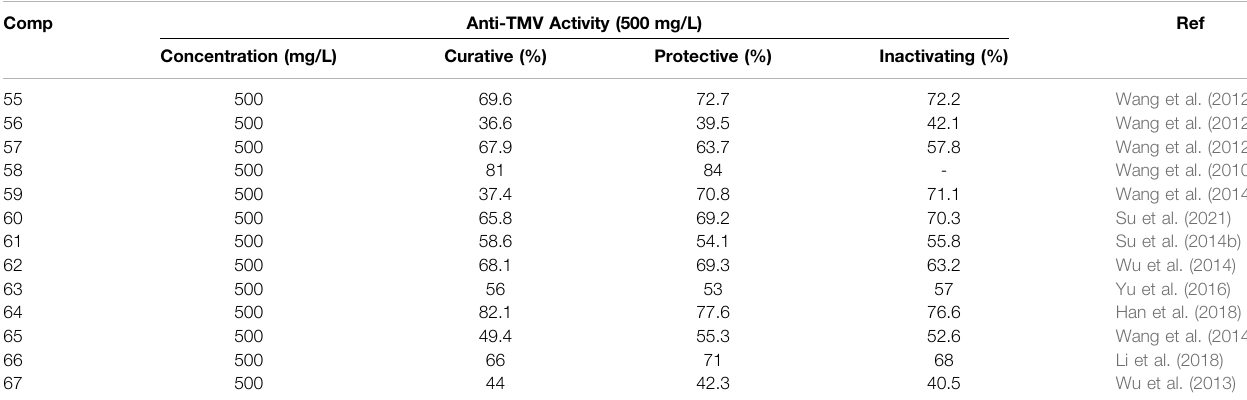
TABLE 2 | Antiviral activity of other representative tylophorine analogues.